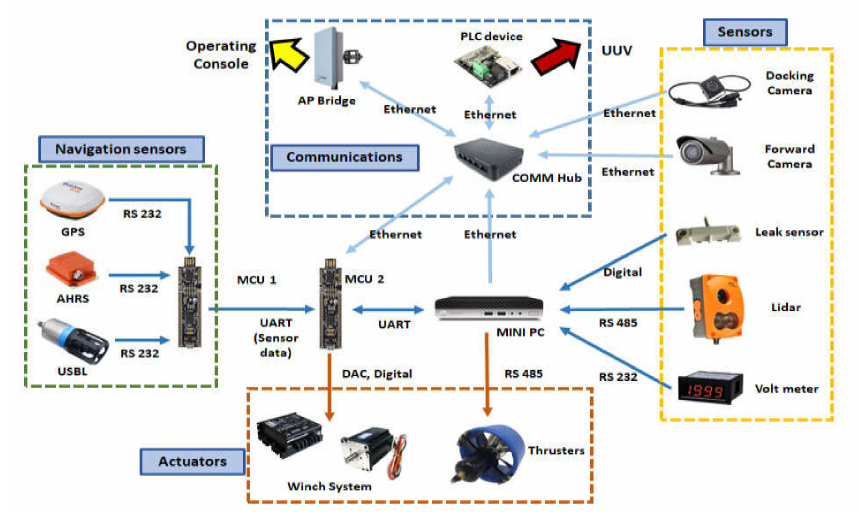
Figure 12. Diagram of USV control system.